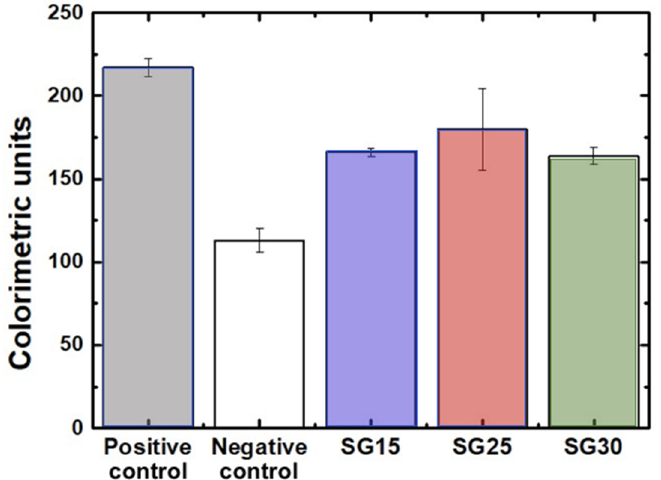
Figure 12. Alizarin red staining (red) reveals the effect of aerogels SG15 ( a , b ), SG25 ( c , d ), SG30 ( e , f ). Positive and negative controls are shown in ( g , h ), respectively. Scale bar represents 20 µ m in all cases.